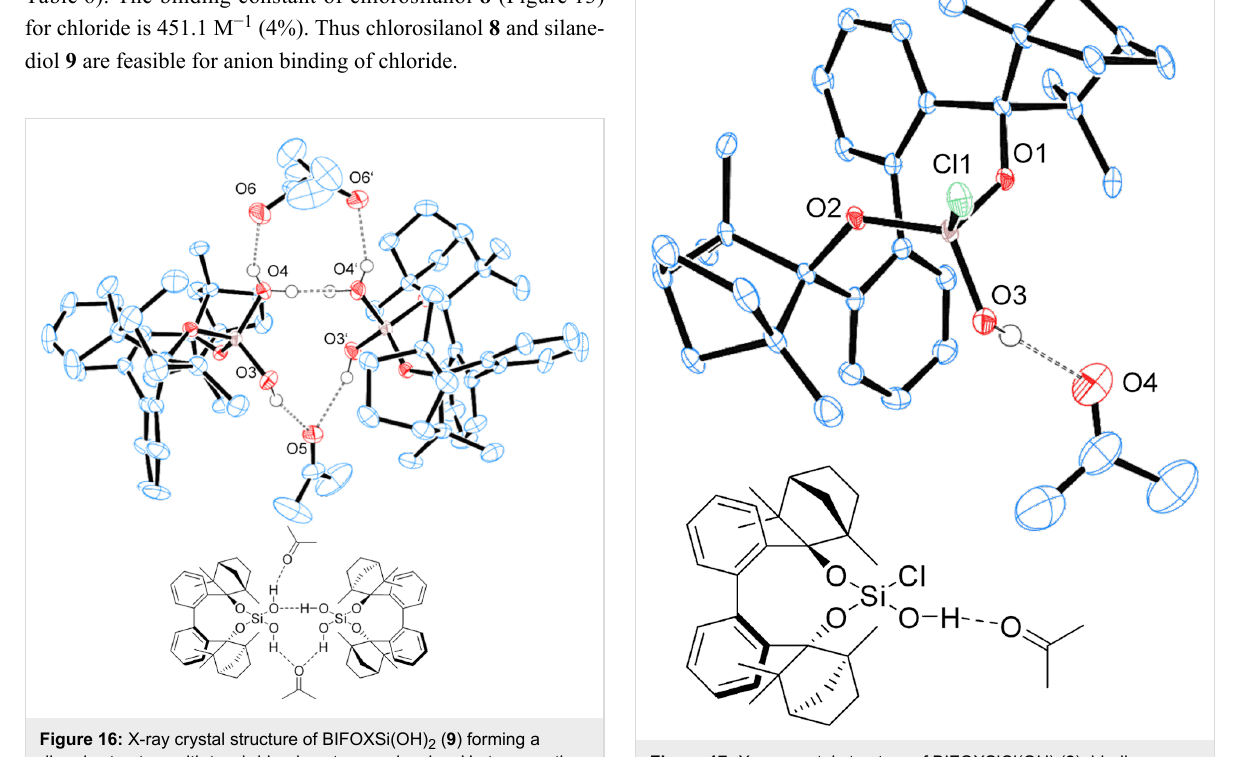
Figure 17: X-ray crystal structure of BIFOXSiCl(OH) ( 8 ), binding an acetone molecule. H atoms on the chiral backbone are omitted for clarity issues and the ellipsoids are shown with 65% probability. For bond lengths and angles see Table 5.